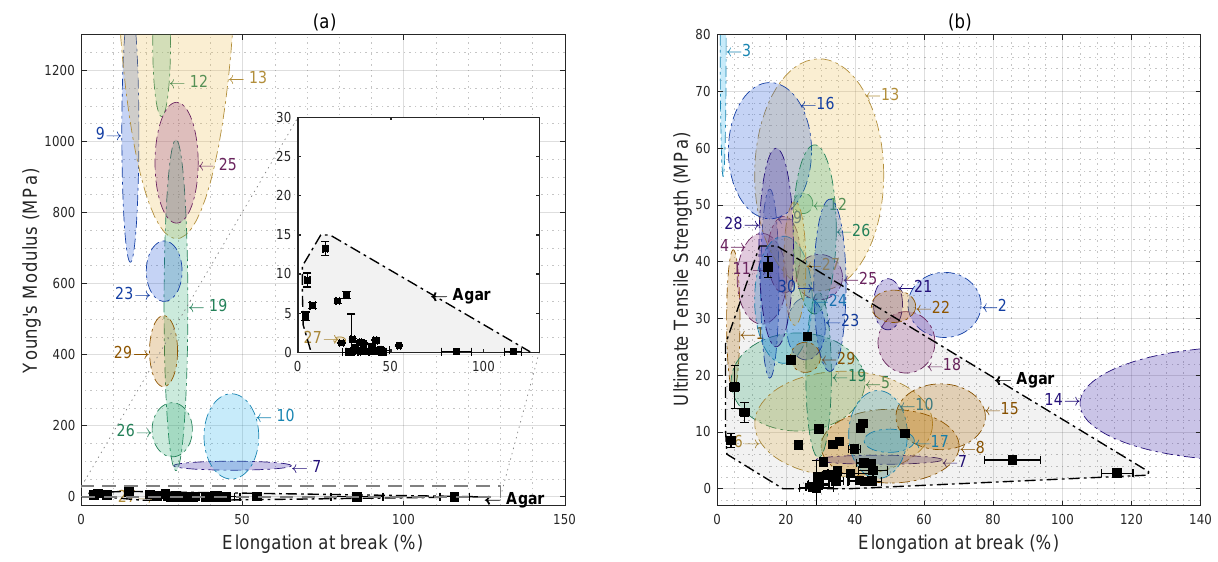
Figure 3. Comparison of results with agar-based films, illustrating ( a ) Young’s modulus versus elongation at break, and ( b ) ultimate tensile strength versus elongation at